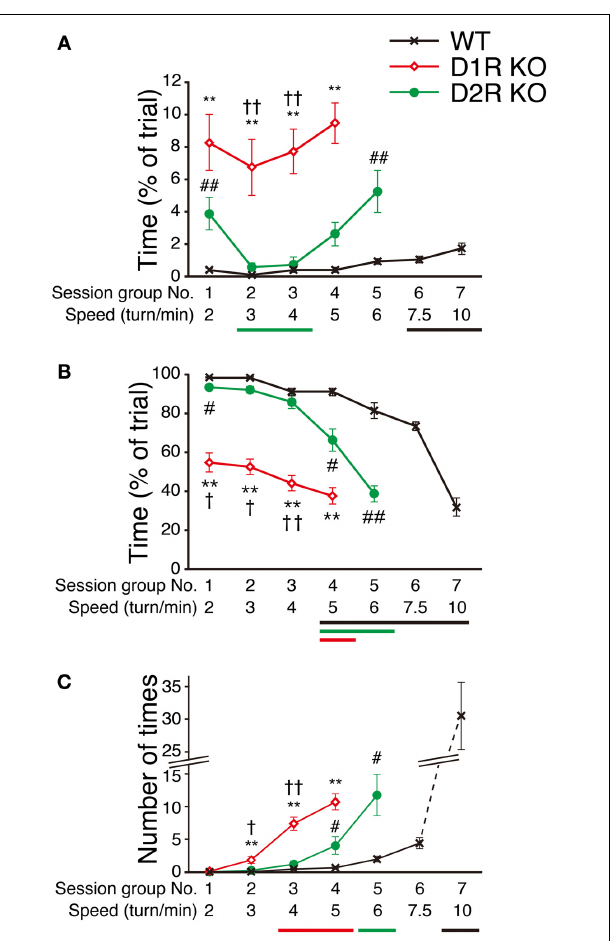
FIGURE 6 | Performance in Step-Wheel task. (A) Touch Time (% of trial), (B) Water On Time (% of trial), and (C) number of Turn Stops are represented as group means ± s.e.m. Significantly differences in performance between genotypes were found on days marked by ∗ p < 0 . 05, ∗∗ p < 0 . 01 for D1R KO vs. WT mice; # p < 0 . 05, ## p < 0 . 01 for D2R KO vs. WT mice; † p < 0 . 05, †† p < 0 . 01 for D1R KO vs. D2R KO mice (Kruskal–Wallis test). Significant improvement of performances compared with that on the 1st day was found on days marked by horizontal bars shown under the graphs ( p < 0 . 05, Dunnett test; WT, black; D1R KO, red; D2R KO, green).